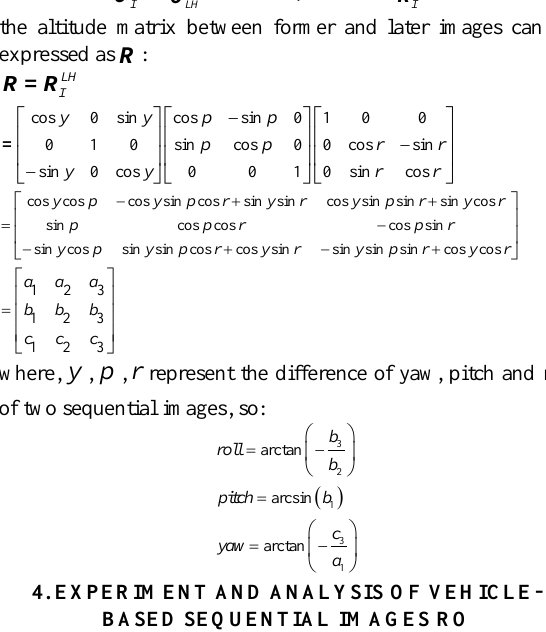
Figure1. The RO procedures of sequential images based on CV